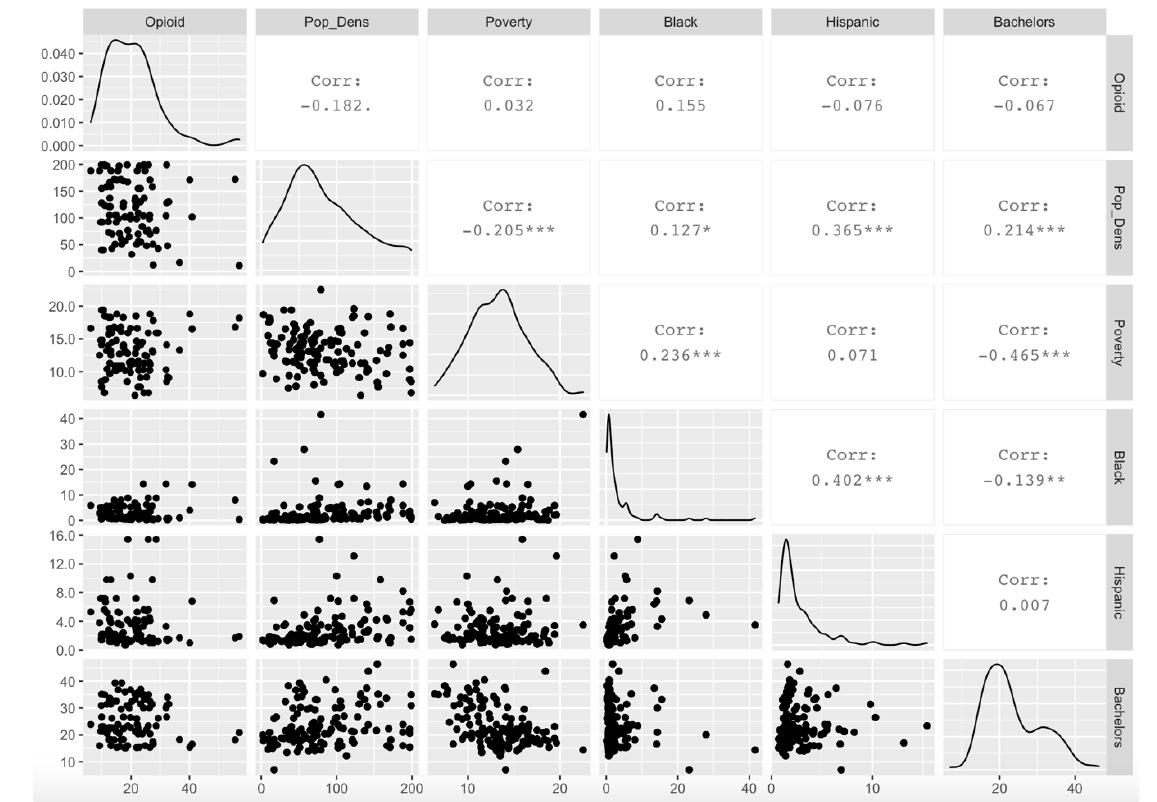
Figure A6. Cross-correlations between explanatory variables for rural counties. * Indicates statistically significant correlation between the corresponding variables, * <0.05, ** <0.01, *** <0.001.